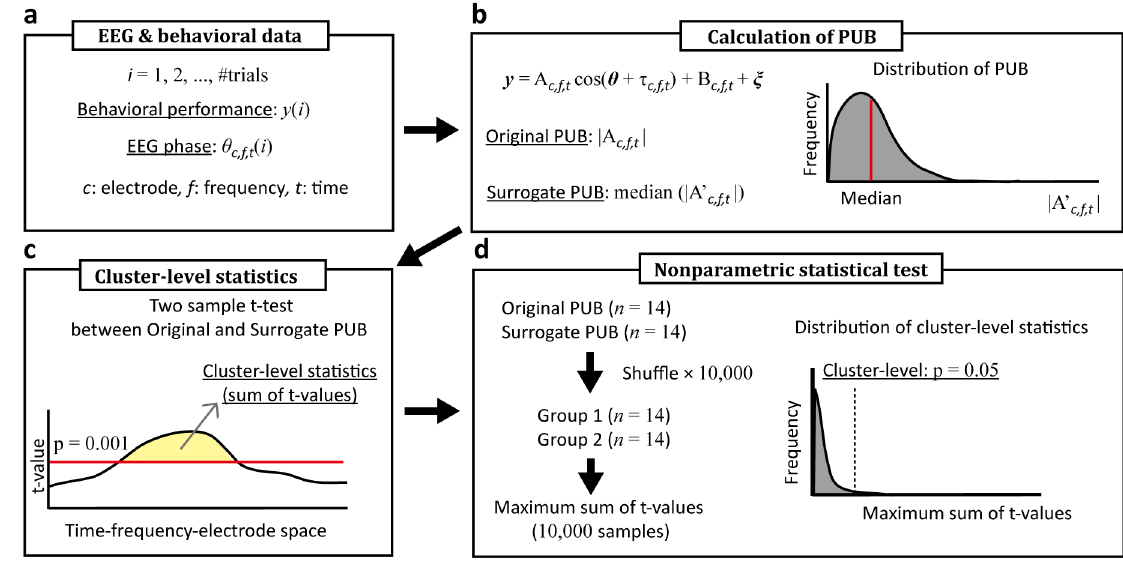
Fig 2. Schematic illustration of the cluster-level statistical test. (a) The EEG was decomposedinto instantaneous phases. (b) The originalPUB and surrogate PUB were calculatedfrom the EEG phases and behavioral performance data. (c) Clusters in the time-frequency-electrodespace were decidedbasedon the thresholdof the t-value, and the cluster-level statistics were computed. (d) The cluster-level statistics were tested by the empiricaldistributionof the maximum cluster-level statistics.